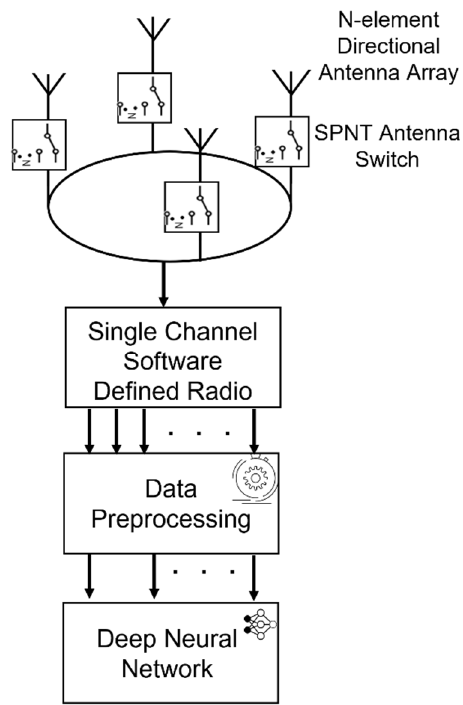
Figure 2. Diagram of the system model in [10] .